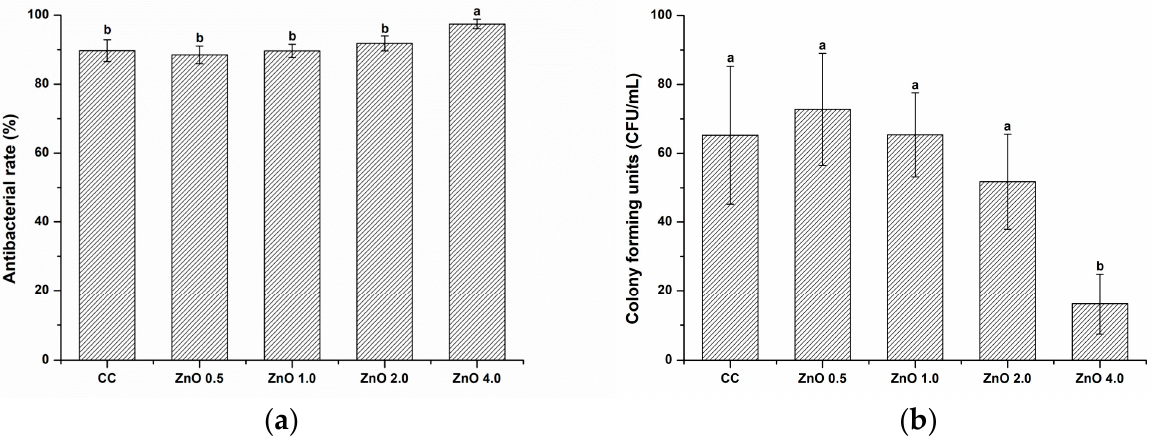
Figure 4. Quantitative evaluations of the antibacterial effect: ( a ) antibacterial rate (%); ( b ) colony- forming units of the experimental materials. Different letters indicate significant differences ( p < 0.05). The error bars show the standard deviation of the mean values.